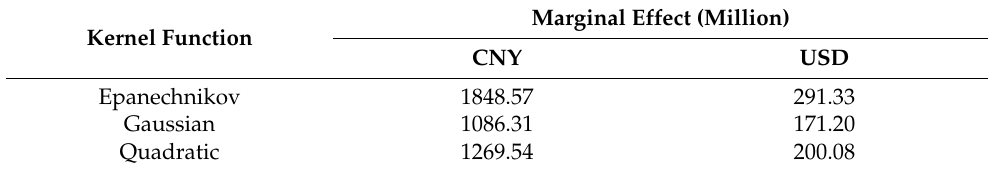
Table 7. The marginal effect of industrial value added under different kernel functions. Kernel